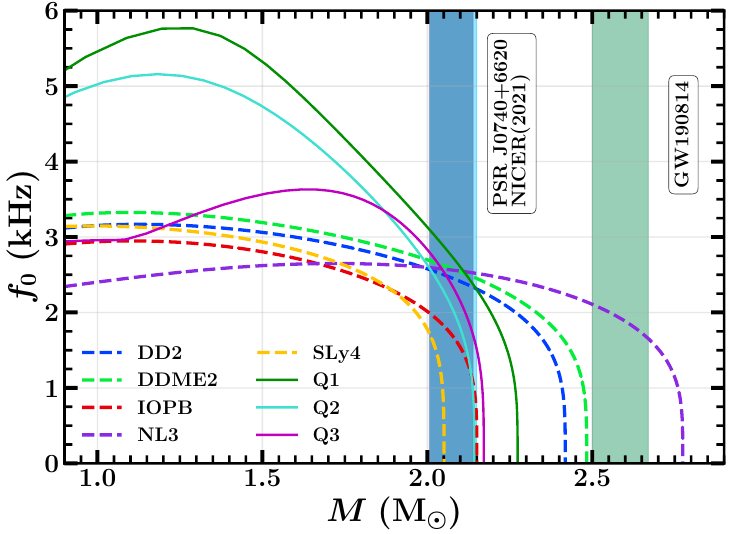
Figure 5. The f-mode frequency vs. mass curves for our choice of EoSs. The blue vertical bands represent the 2021 NICER data with XMM mass observations of PSR J0740+6620 [55], and the green vertical band represents the mass data from the GW190814 merger event